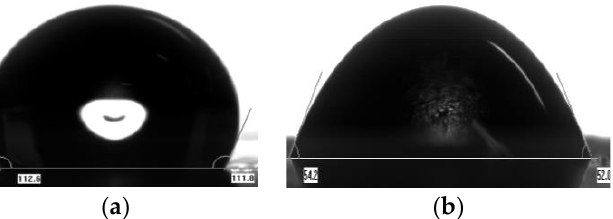
Figure 3. Contact angle of coal sample. ( a ) Contact angle of low-ash cleaned coal; ( b ) Contact angle of artificially mixed coal sample.